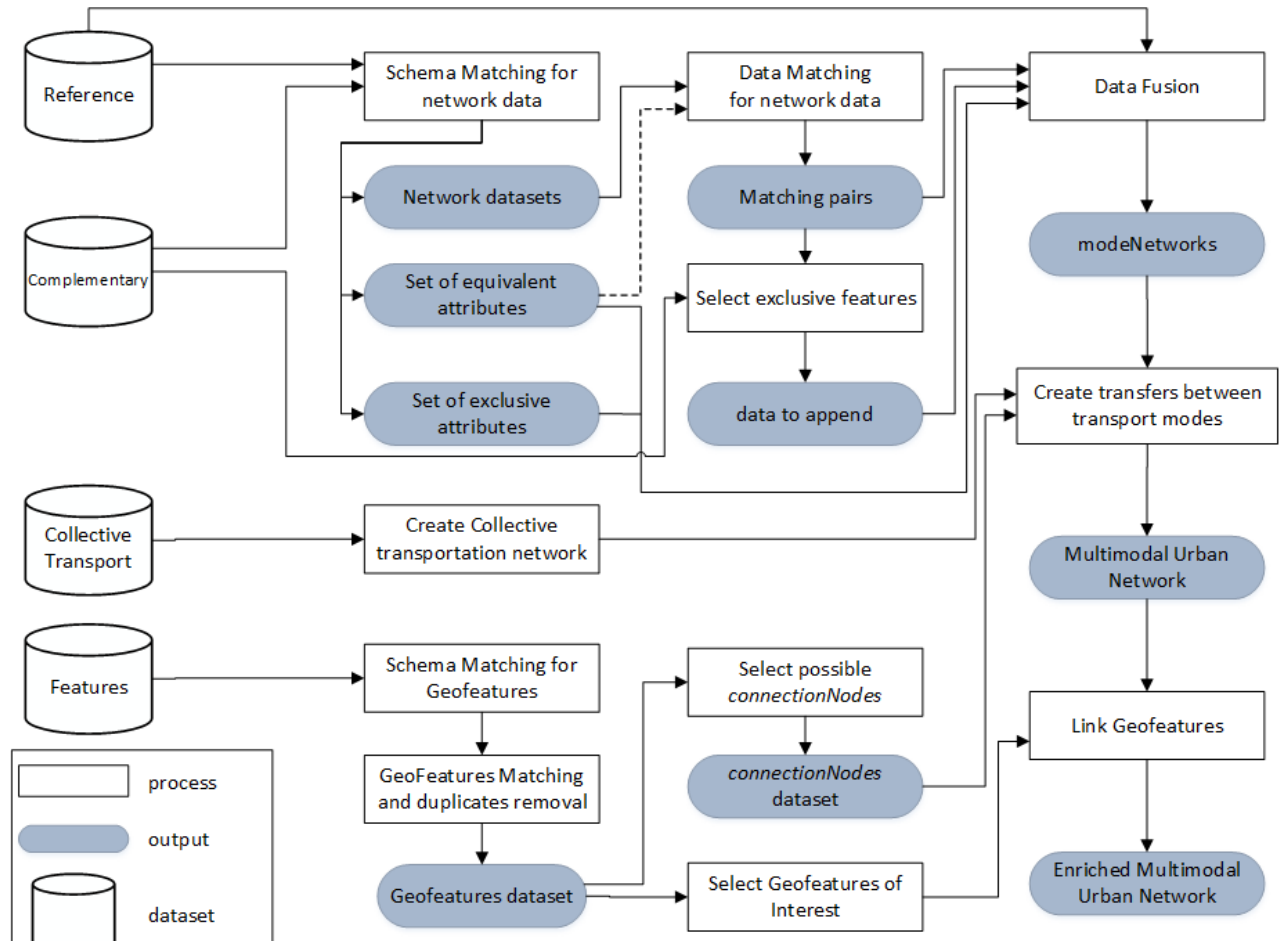
Figure 3. An overview of the steps for building the multimodal